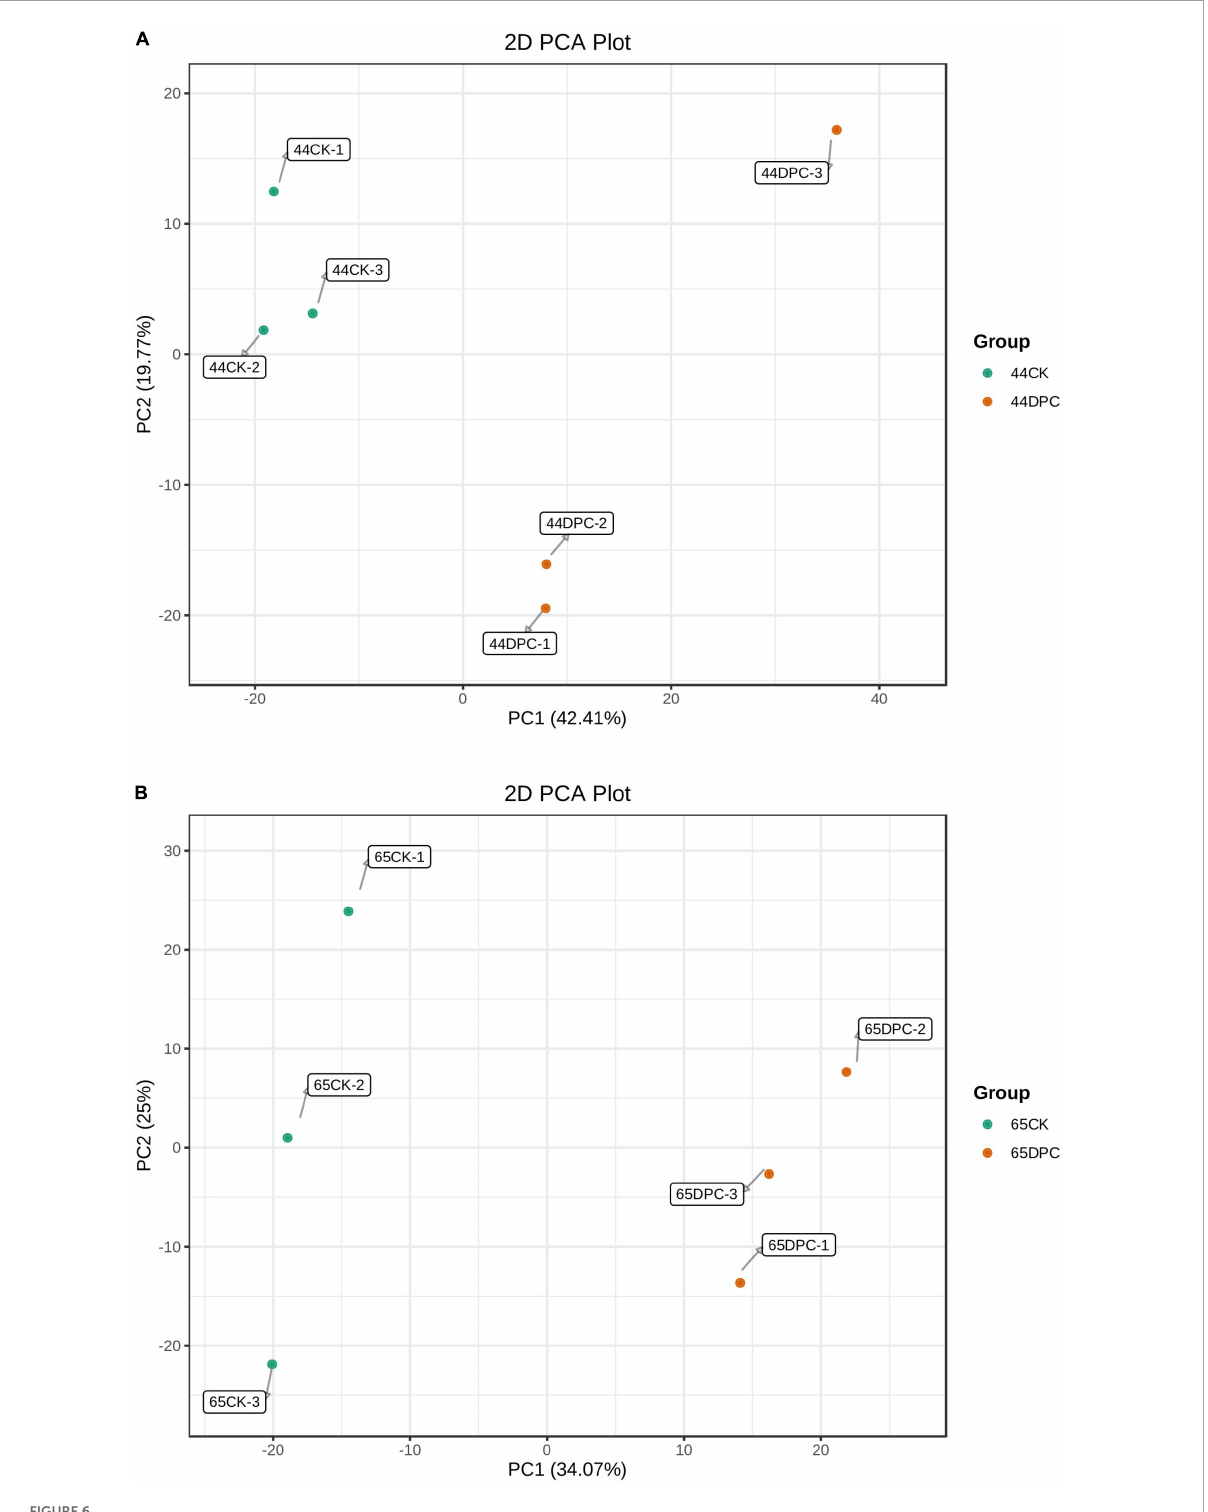
FIGURE6 PCA score chart of mass spectrometry data of each sample and quality control sample. PC1 represents the first principal component, PC2 represents the second principal component, and the percentage represents the interpretation rate of this principal component to the dataset; each point in this figure represents a sample, and samples in the same group are represented by the same color. (A) HN44 group; (B) HN65